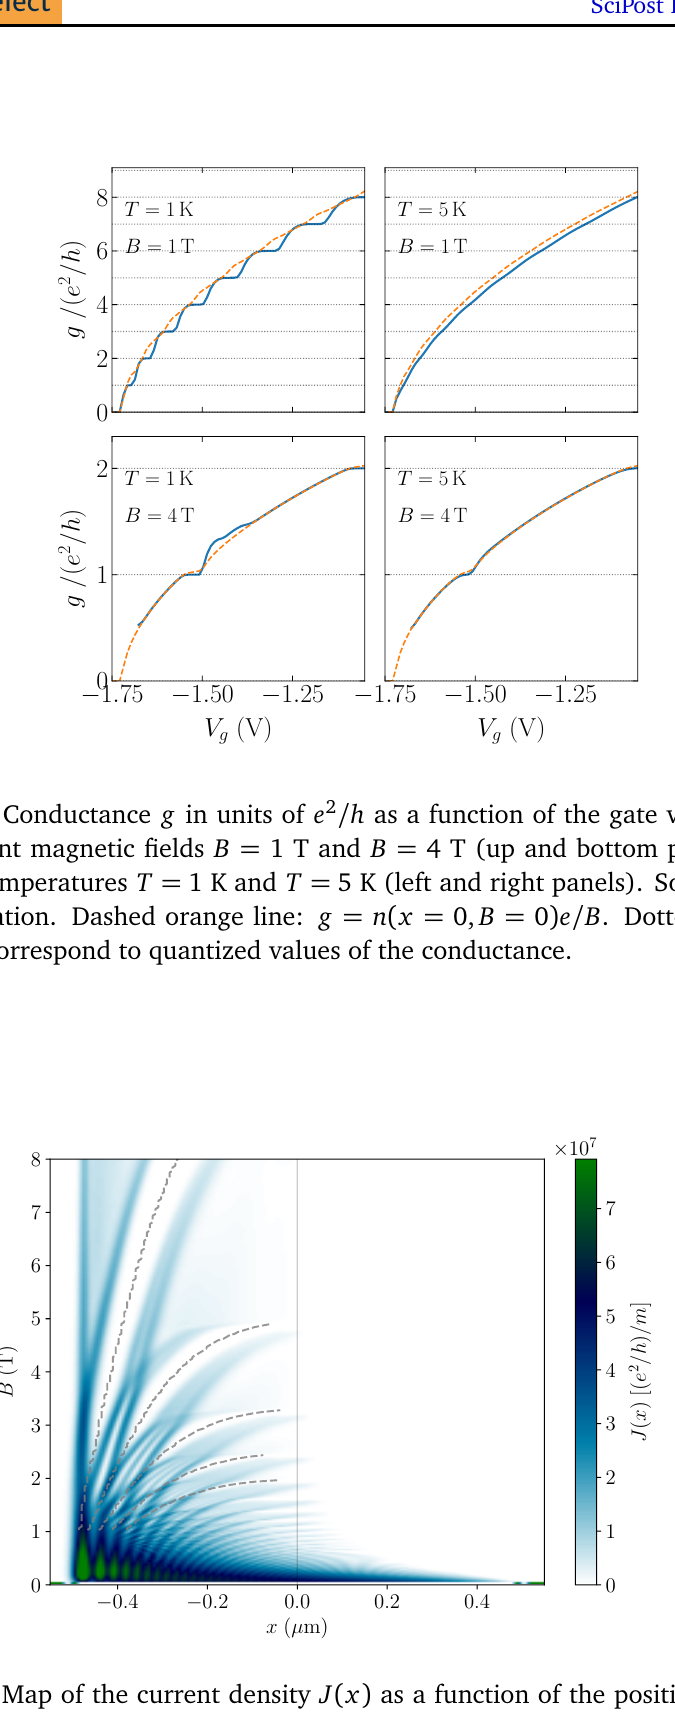
Figure 12: Map of the current density J ( x ) as a function of the position x and the magnetic field B . Dotted lines indicate the centers of the incompressible